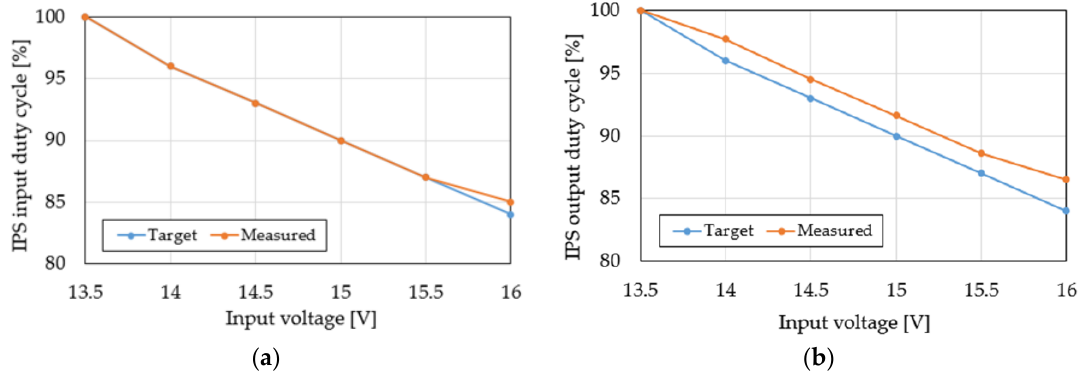
Figure 17. Input and output duty cycles of the IPS for various input voltages: ( a ) IPS input and ( b ) IPS output.